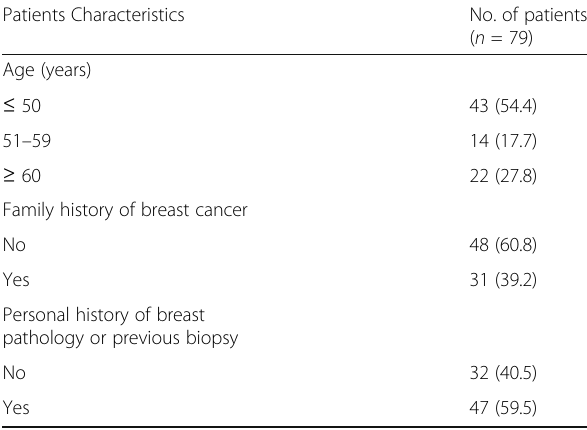
Table 1 Patient characteristics Patients